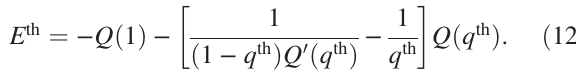
1 . 0 and for various Δ 2 . p ¼